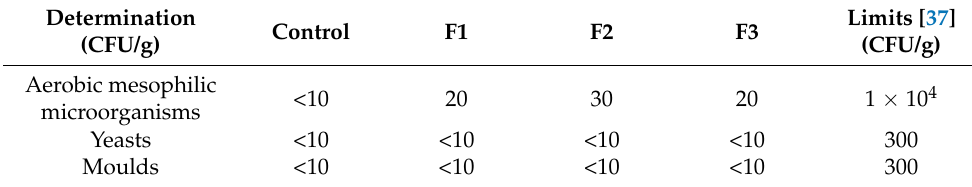
Table 4. Microbial counts of mesophilic microorganisms, yeasts and molds in traditional WWF cook- ies and those produced with different formulations of alternative flours from functional ingredients.